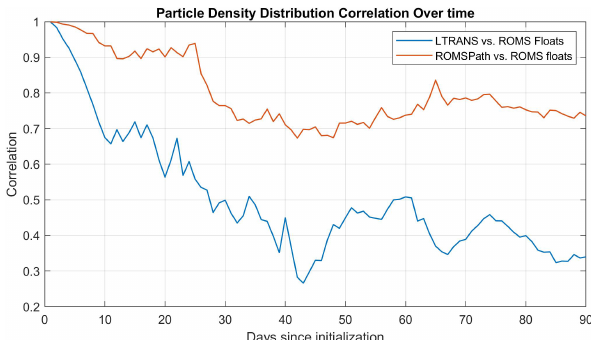
Figure 4. Comparison of particle density distributions over time (Simons et al., 2013). Spatial correlations between ROMSPath (case B) and ROMS floats (case C) are greater than 0.7 for most of the run time. The LTRANS (case A) correlations (with case C) drop below 0.7 within